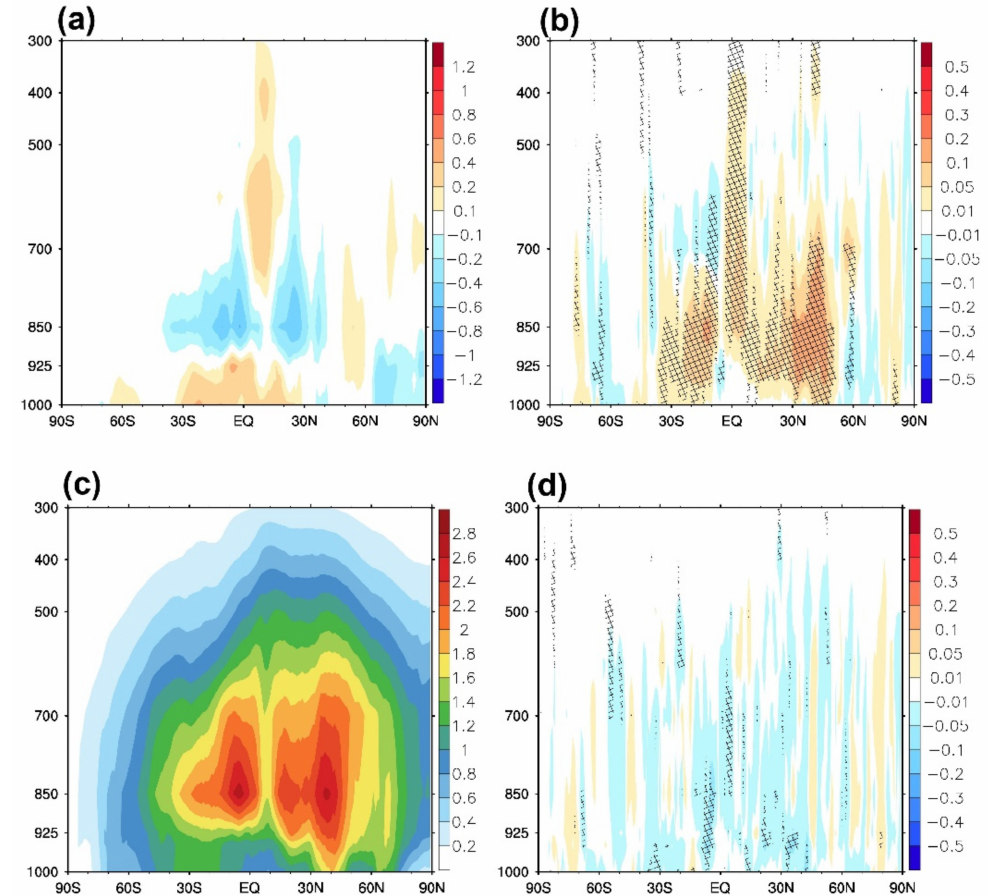
Figure 10. ( a ) Biases and ( c ) RMSEs of the zonal mean specific humidity in the CTL against the ERA5 reanalysis, and ( b ) differences in the biases and ( d ) RMSEs between the EXP and CTL over the period of 1 July 2019 to 10 August 2019 for a five-day forecast. The hatched regions indicate a difference significant at the 95% confidence